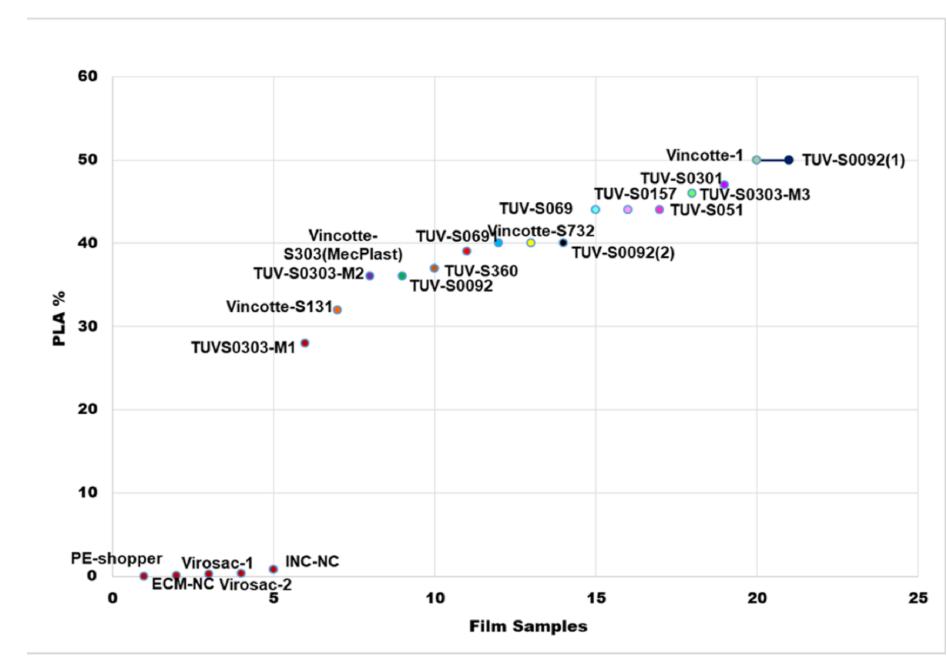
Figure 10. PLA minimum content (%) of the 21 film samples. Table 5. Data used for developing the predictive linear regression model (PLRM). Film